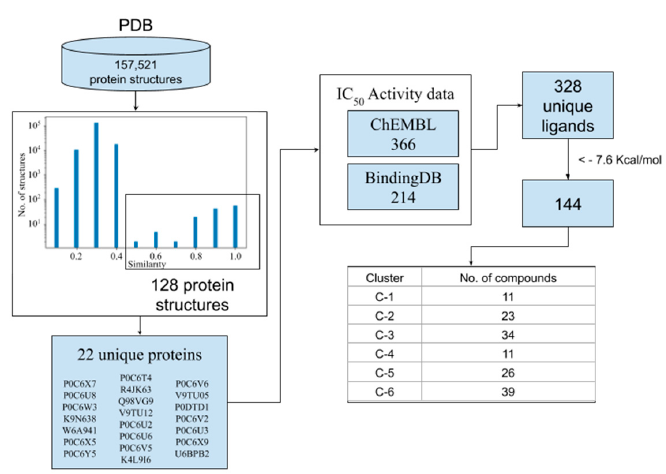
Figure 1. The selection process of compounds from BindingDB and ChEMBL. Selected compounds were classified into six clusters based on MACCS fingerprint similarity.